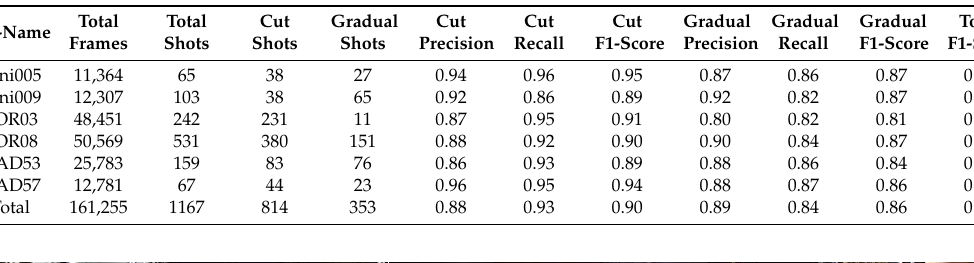
Table 13. Information on the test video and results of shot detection.